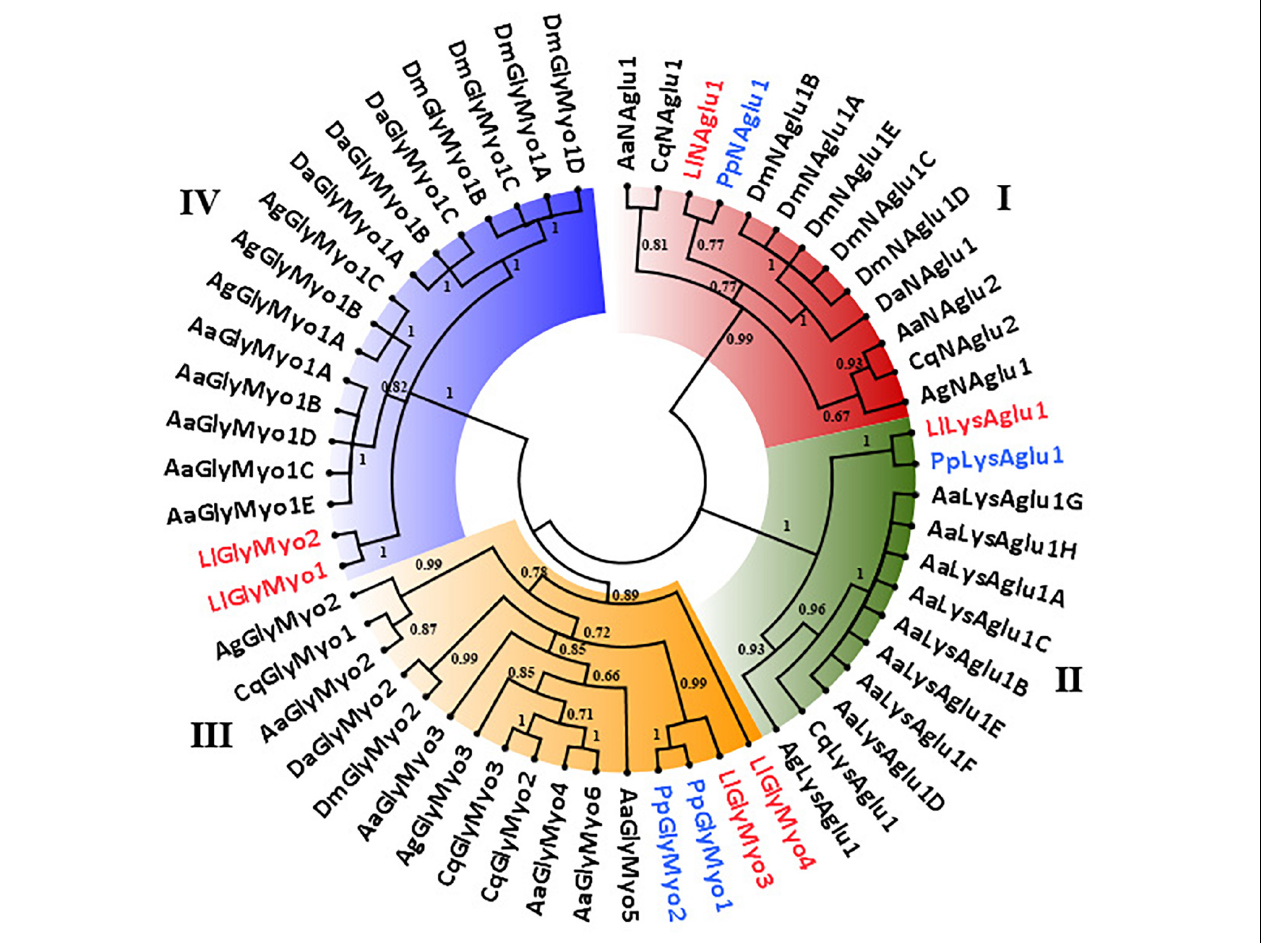
FIGURE 3 | Phylogenetic analysis of L. longipalpis GH31 proteins. Radial cladogram represents the alignment of GH31 protein sequences, neutral α -glucosidases (NAglu, red), lysosomal α -glucosidases (LysAglu, green), Glycosidases NET37 with catalytic domain (GlyMyo, orange), and Glycosidases NET37 with no catalytic domain (GlyMyo, blue) of L. longipalpis and other dipterans species. L. longipalpis sequences are highlighted in red and P. papatasi in blue. Sequences are from L. longipalpis (Ll), P. papatasi (Pp), A. aegypti (Aa), A. gambiae (Ag), C. quinquefasciatus (Cq), D. melanogaster (Dm) and D. ananassae (Da). The tree represents the bootstrap consensus of 500 replicates, visualized with FigTree v1.4.3. Bootstrap values for the nodes are represented. The identifiers and corresponding genes are specified in Additional file